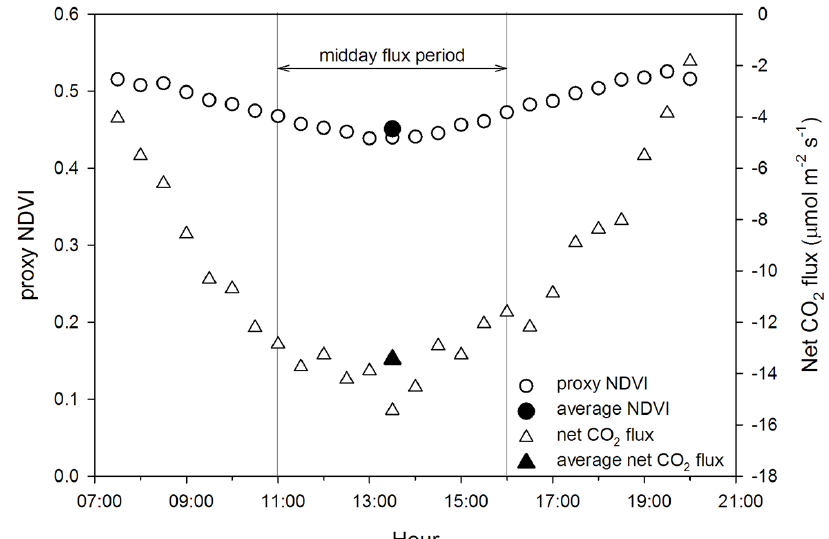
Figure 4. Sample diurnal course of proxy NDVI (from phenology station, circles) and net CO 2 flux (from eddy covariance, triangles), showing average values (open symbols) calculated for the 5-h midday period (arrow between two vertical lines). See Methods and Supplemental Materials for further details on averaging (aggregation). Data from site E3, 7 June 2012.